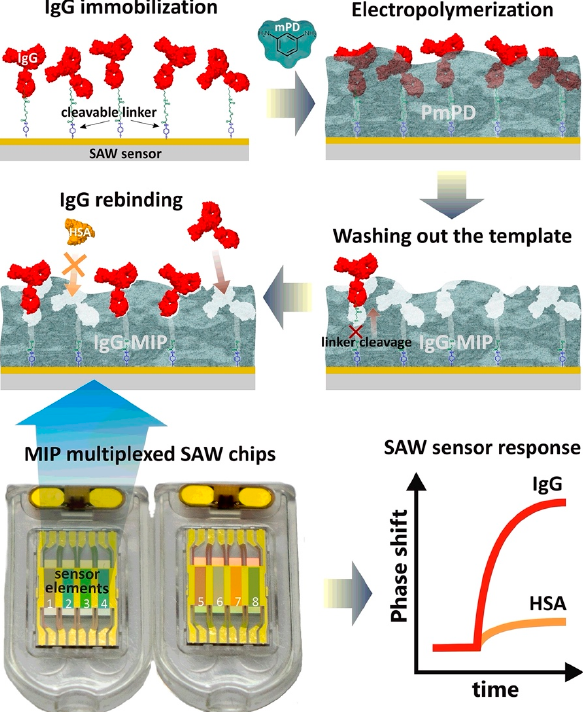
Figure 7. Schematic image of the synthesis procedure for IgG-MIP sensing layer in combination with SAW sensor chip. Reprinted from [81] with permission from Tretjakov et al.